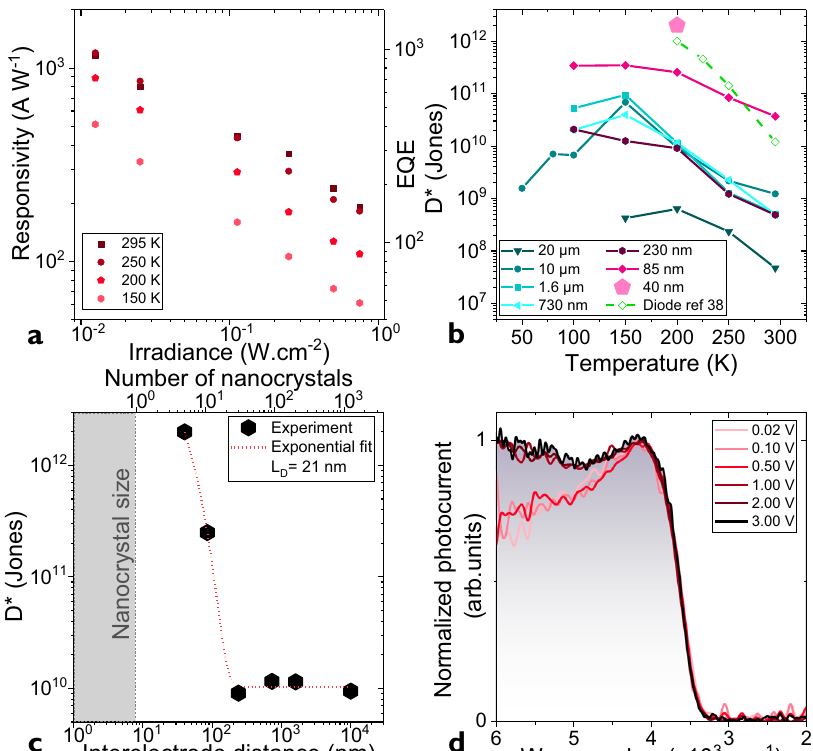
Fig. 3 Infrared detection using nanotrench device. a Responsivity and external quantum ef fi ciency (EQE) as a function of the incident power for an array of HgTe nanocrystals (NCs) deposited on nanotrench electrodes (nanotrench spacing: 40 nm) at various temperatures. Applied bias is 1 V, while the illumination is ensured by a 1.55 µ m laser diode and modulated at 1 kHz. b Speci fi c detectivity, D* under 1 V as a function of the temperature for various devices: 10 and 20 µ m-spaced interdigitated electrodes, e-beam fabricated electrodes with 230, 730, and 1600 nm spacing and nanotrenches electrodes with 40 and 85 nm spacing. For the sake of comparison with state of the art diode we also provide the performance of the photodiode from ref. 38 . c Speci fi c detectivity measured at 200 K as a function of the electrode spacing. An exponential fi t which characteristic decay length is 21 nm is also plotted in red. d Photocurrent spectra for an array of HgTe NCs deposited on nanotrench electrodes (electrode spacing: 85 nm) and various applied bias. Measurement is conducted at 200